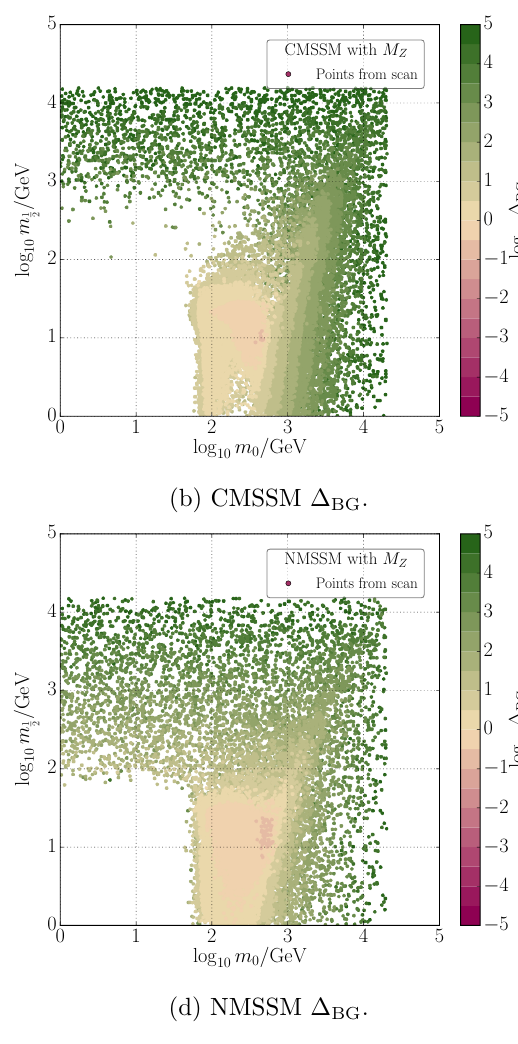
Figure 2. Credible regions of marginalized posterior probability density conditioned upon M Z (left) and pro(cid:12)led BGEN measure (right) for the CMSSM (upper) and NMSSM (lower) on the ( m 0 , m ) 1 = 2